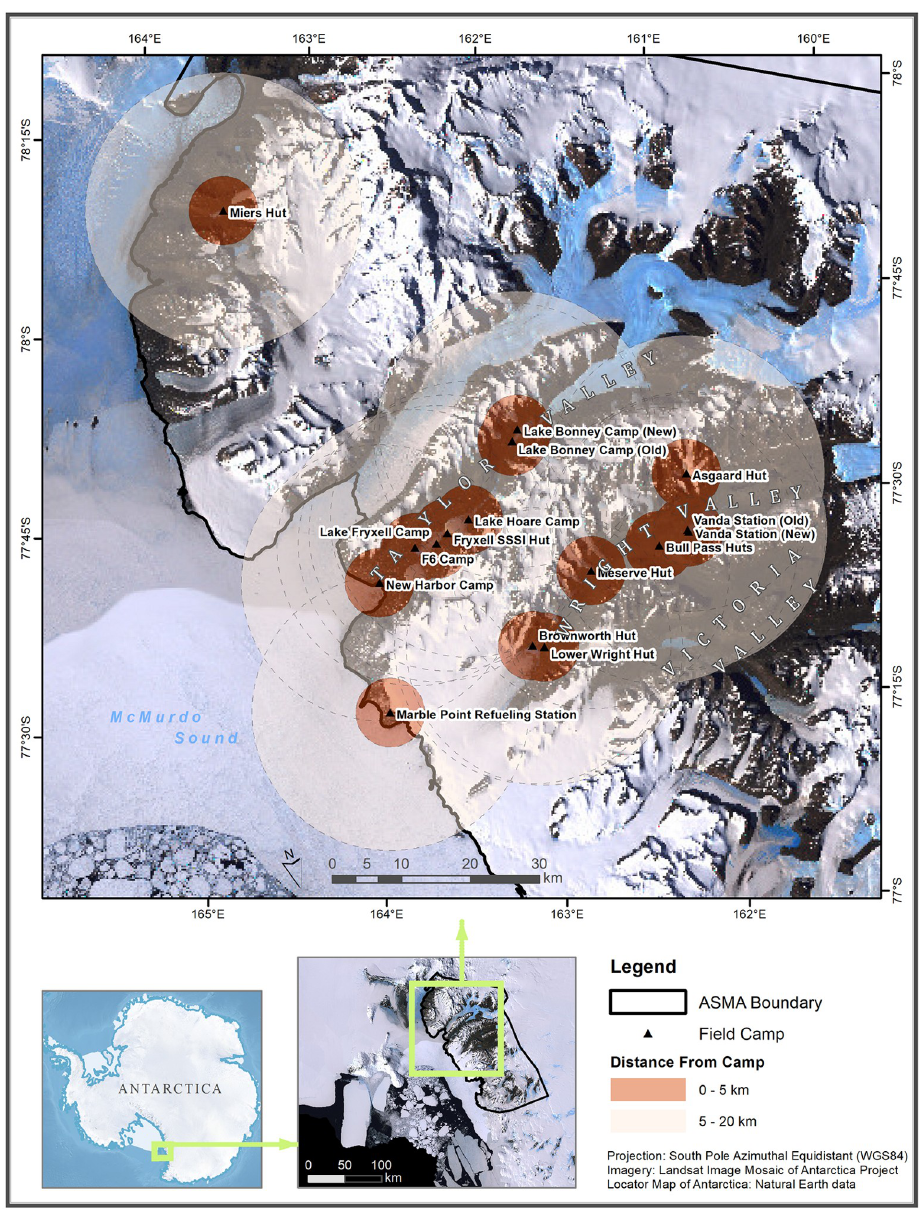
Fig 2. Map of the McMurdo Dry Valleys and associated Antarctic Specialty Managed Area (ASMA). Locations of the 16 historic and current semi-permanent field camps are shown with 5 km (‘local’) and 20 km (‘distant’) circular buffers, overlain on satellite imagery